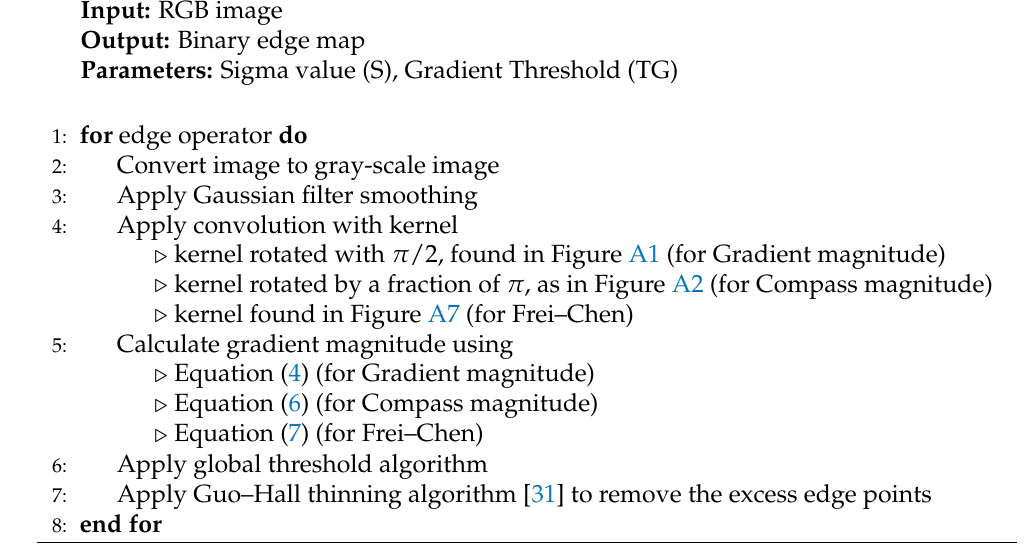
Algorithm 2 First-Order Derivative Operators